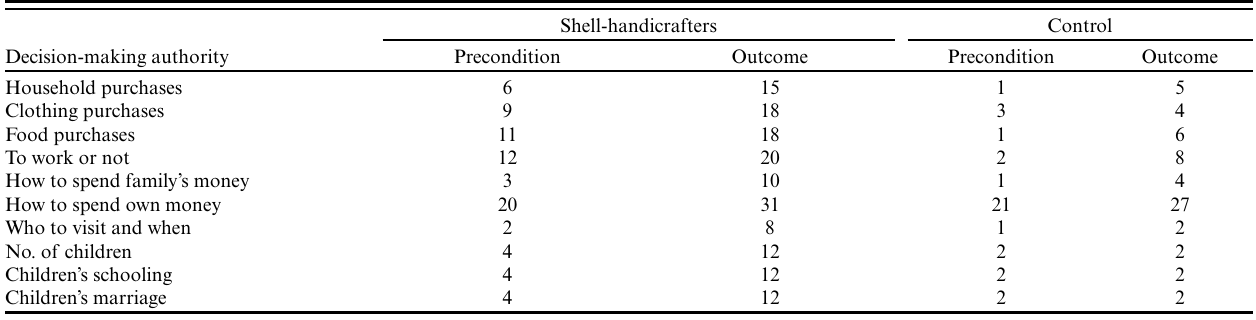
Table 1 . Precondition and outcome in decision-making authority. Data based on interviews with women engaged in shell-handicraft (n = 36) and control group (n = 36). “Yes” indicates decision-making authority.